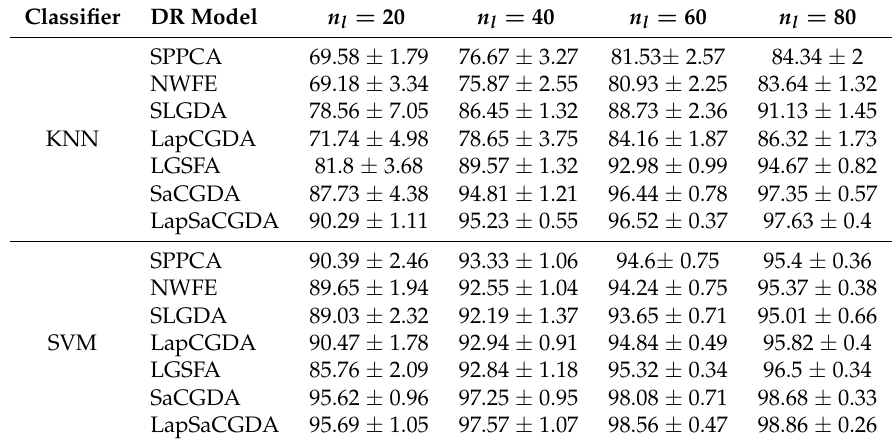
Figure 5. Classification accuracy w.r.t. different dimensionality of the projection space on the Pavia University data: ( a ) OA based on KNN; ( b ) OA based on SVM. Table 2. Classification results with different amounts of training data on the Pavia University data (OA ± STD